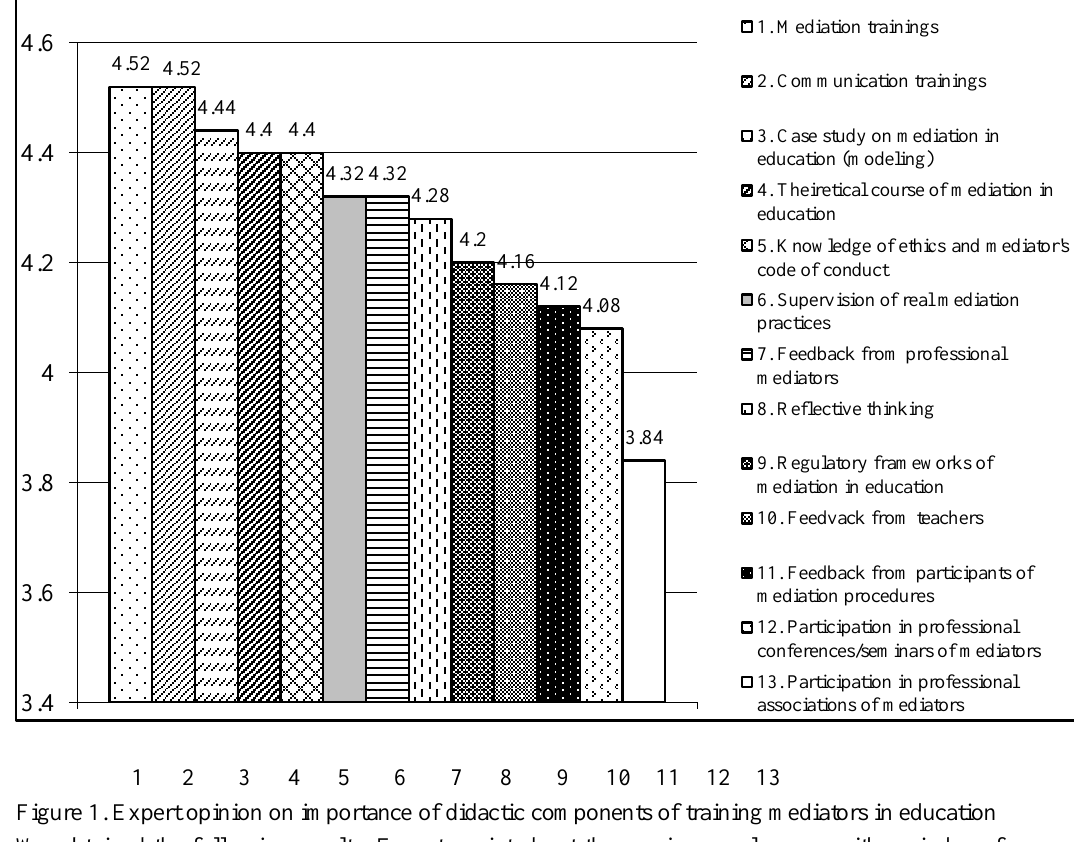
Figure 1. Expert opinion on importance of didactic components of training mediators in